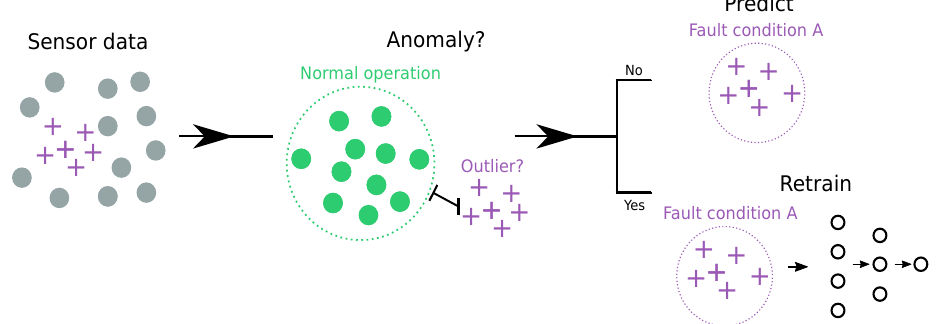
Figure 1. A visualization of the condition monitoring system. The sensor data is propagated through the machine learning framework, and the model detects whether the data point is an outlier. If it is an outlier, the sensor data must be manually inspected, and the machine learning framework retrained. If the incoming sensor data is not an outlier, the framework will predict the state of the condition. If the fault state is detected, as a fault, maintenance will be scheduled